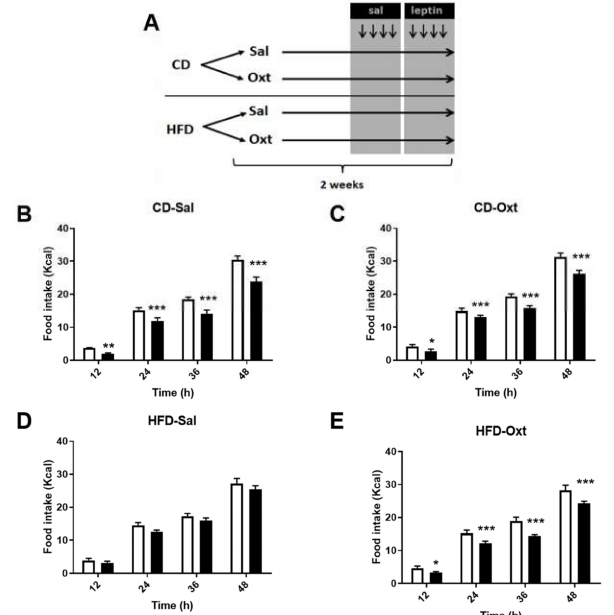
Figure 1. Acute leptin effects on food intake. ( A ) Experimental design described in Material and Methods. Mice were fed a chow diet (CD) or a high fat diet (HFD) during 10 weeks. The last two weeks, mice were infused subcutaneously with the vehicle (saline, Sal) or oxytocin (Oxt, 50 µ g/day). At days 10–13, they were IP injected twice per day (7:00 and 19:00) with saline (days 10–11) and leptin (days 12–13). ( B – E ) Cumulative food intake at the indicated timings in the different groups. White bars, saline; black bars, leptin (1.5 mg/kg). Statistical significance was analyzed by two-way repeated measures ANOVA with an FDR Benjamini and Hochberg’s post-hoc test, * p < 0.05, ** p < 0.01, *** p <